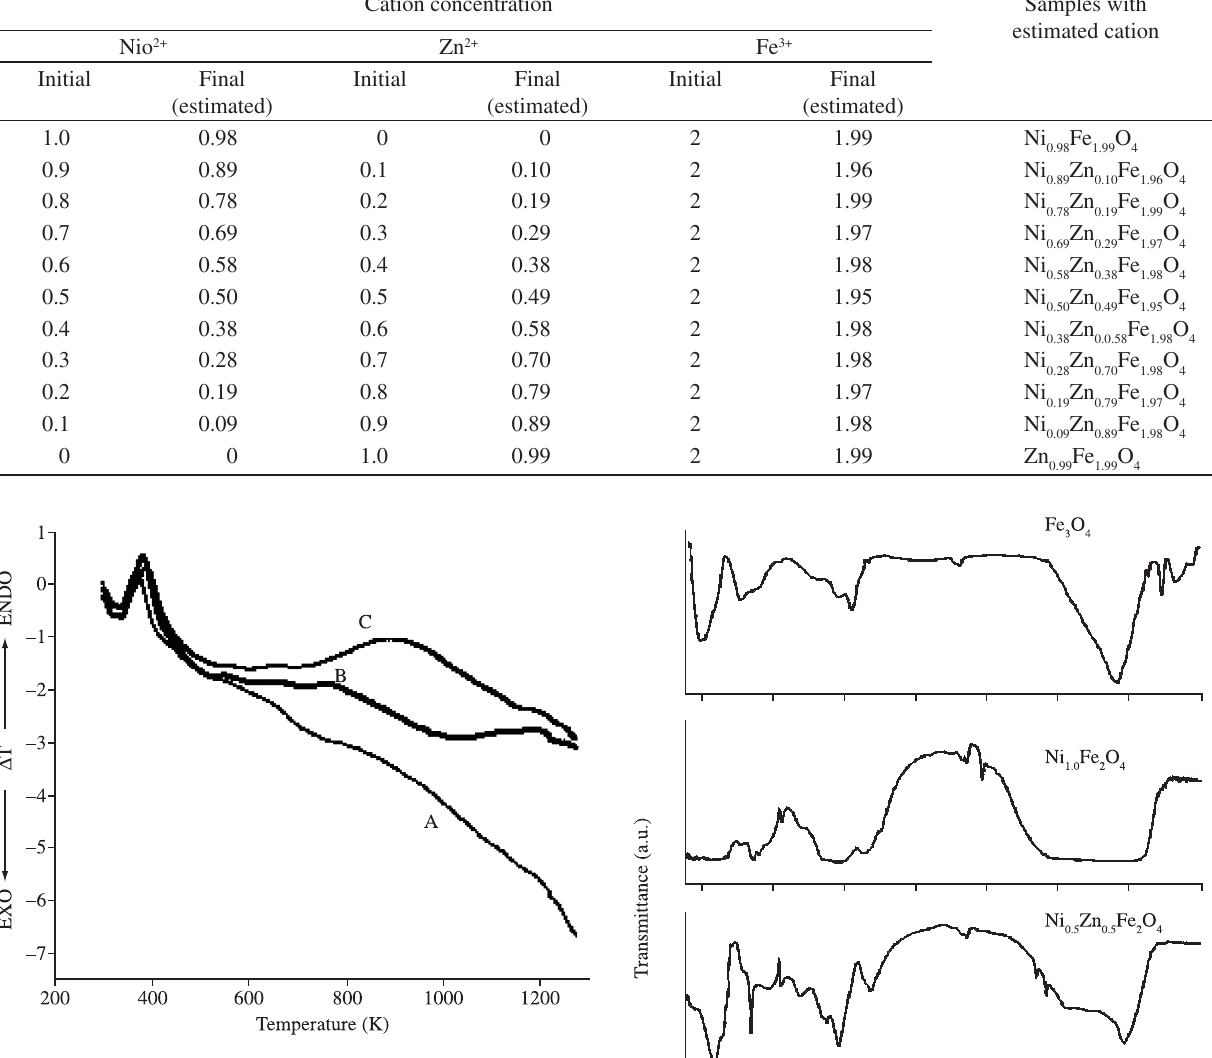
Fe O (B) Ni 1.0 2 4